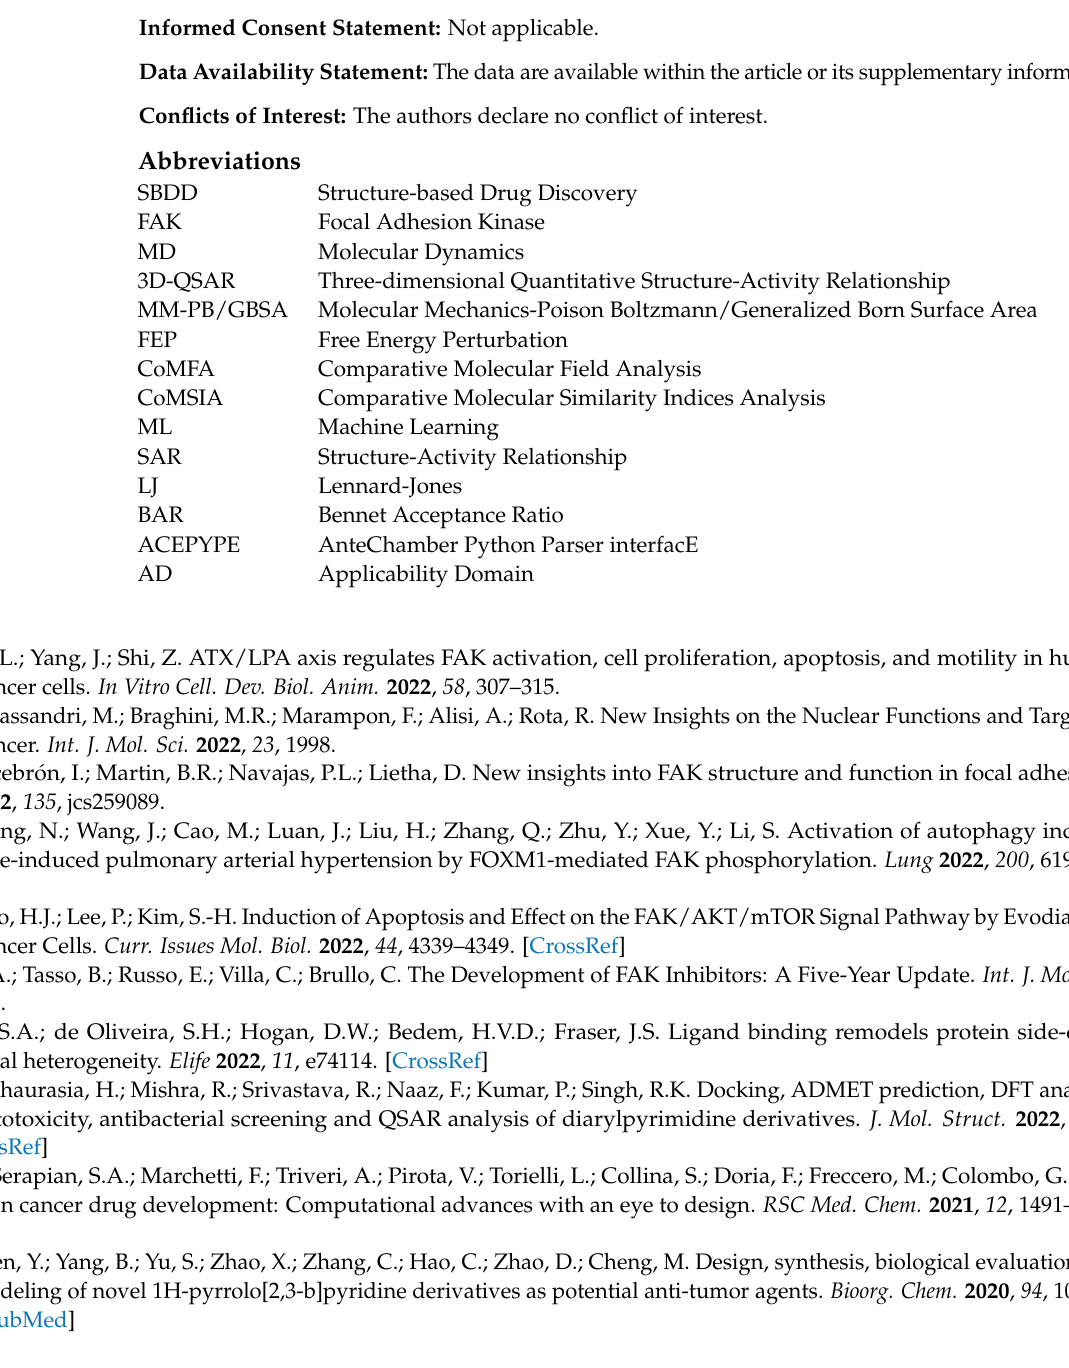
the test set compounds; Table S5: Statistics of CoMSIA model development; Table S6: Actual vs. predicted pIC 50 values of CoMFA and CoMSIA (SET-D) models; Table S7: λ parameters to gradually change the ligand interaction from state-A to